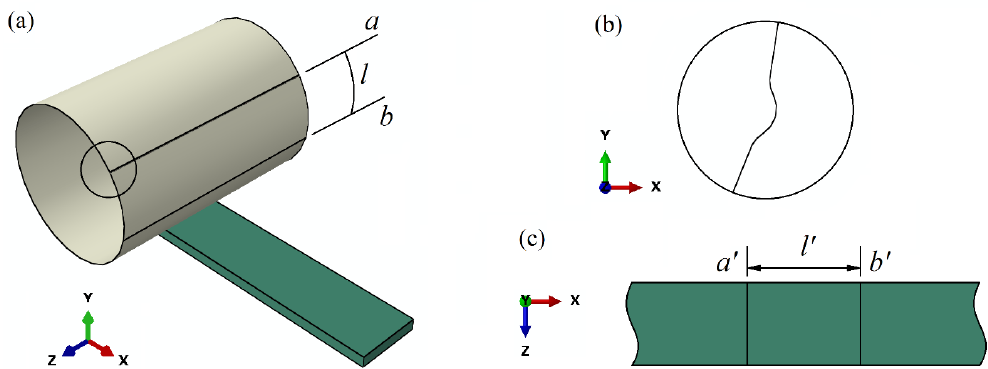
Figure 2. Schematic of strip marking method for numerical estimation of forward slip in micro flexible rolling: ( a ) Finite element analysis model with two parallel ridges running axially along roll surface; ( b ) enlarged profile view of the ridge; and ( c ) rolled strip with two line markings indented by the ridges.